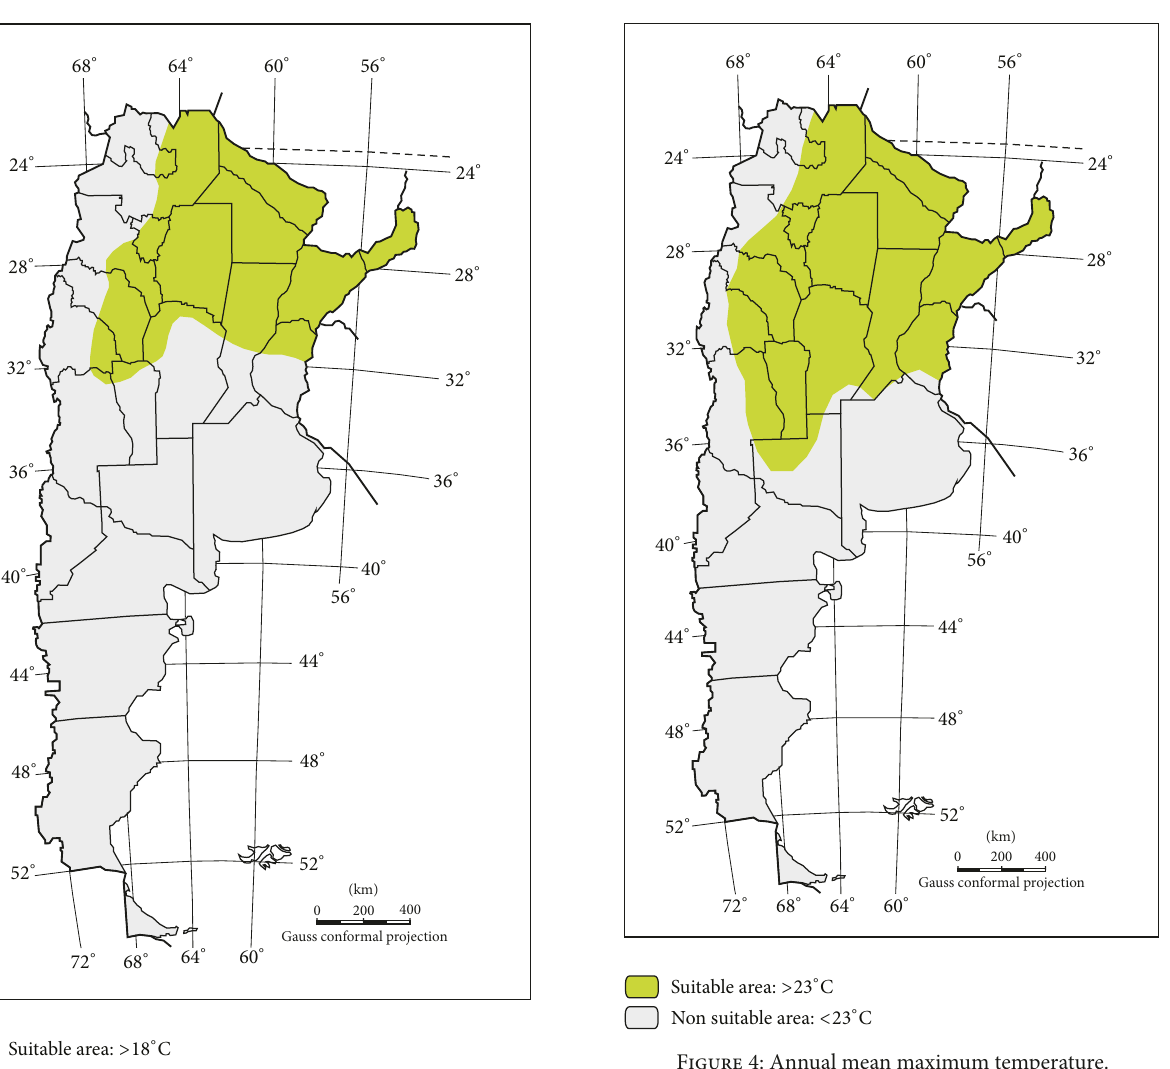
Figure 3: Annual mean temperature.